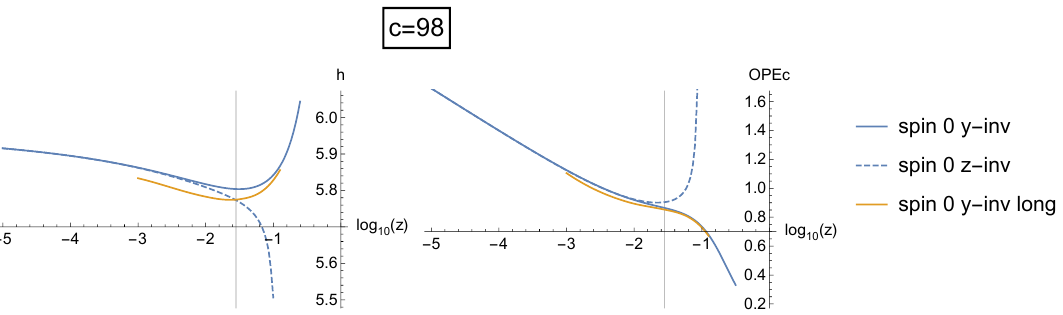
Figure 8. Short and long (up to spin 16) inversion results for spin 0 long multiplet with c = 98 . The vertical lines on both plots pass through log z = − 1 . 55 , and this is our choice for the finite 10 y inversion. The orange curves indicate that the plateau regions remain largely unchanged after adding the long multiplet contribution. We also included plots using the z variable for